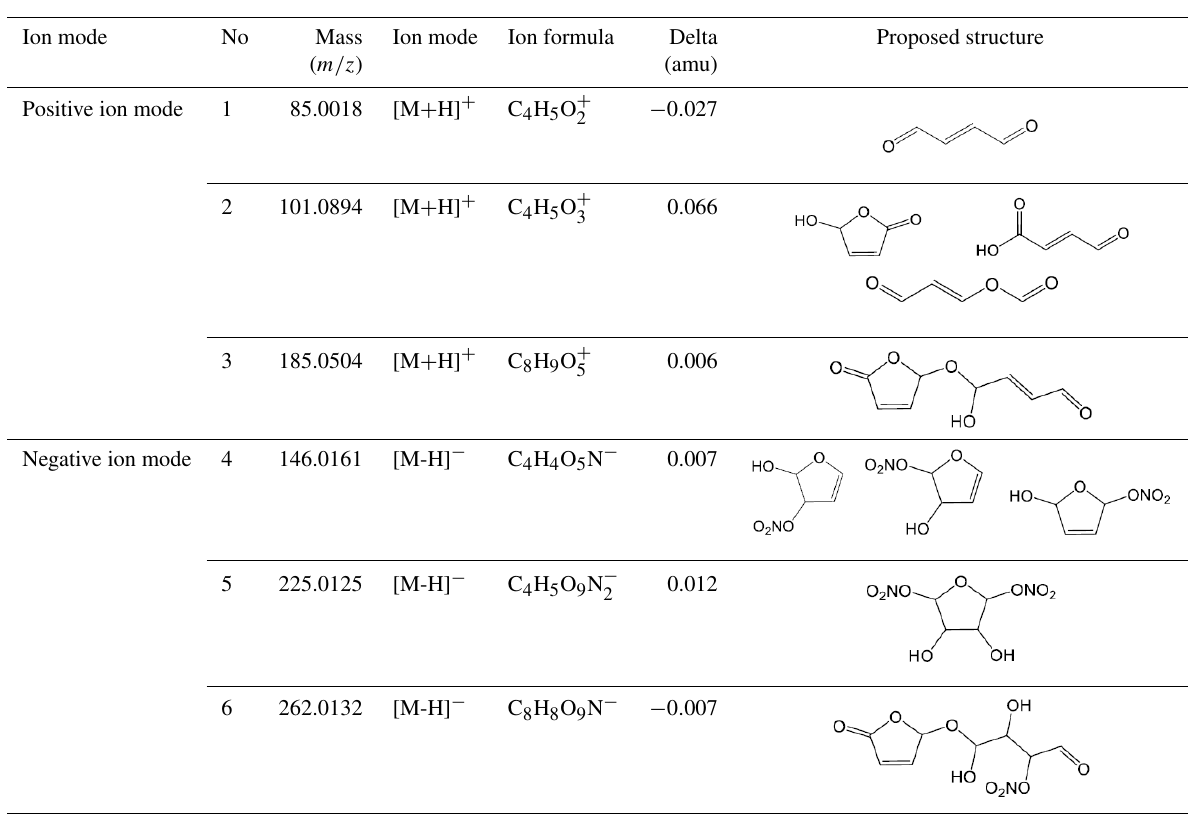
Table 3. Ion peaks with the assigned compounds observed in the HESI-Q Exactive-Orbitrap MS. Proposed assignments are based on the formula from HESI-Q Exactive-Orbitrap